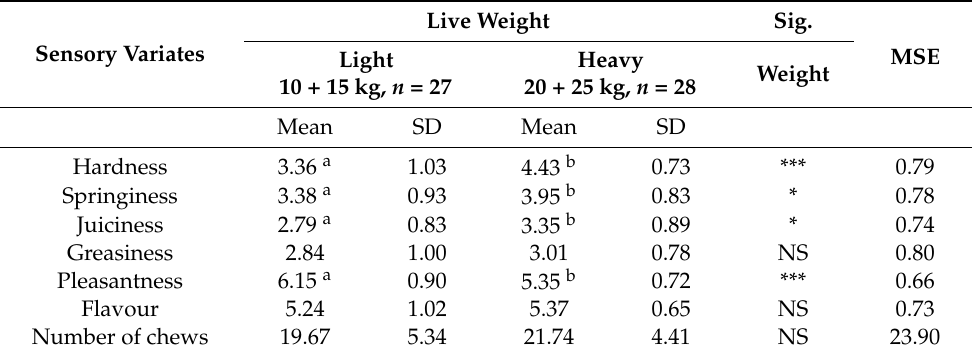
Table 6. Means and mean square error (MSE) of the sensory parameters of Rubia de El Molar lambs’ meat in the light and heavy classes of lambs. Live Weight Sig. Sensory Variates MSELight 10 + 15 kg, n =